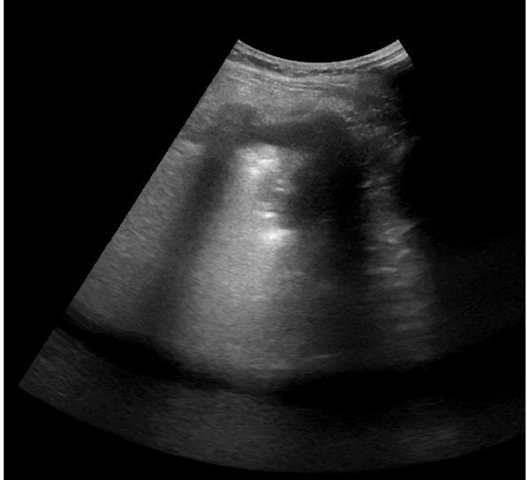
Figure A5. Pleural fluid.